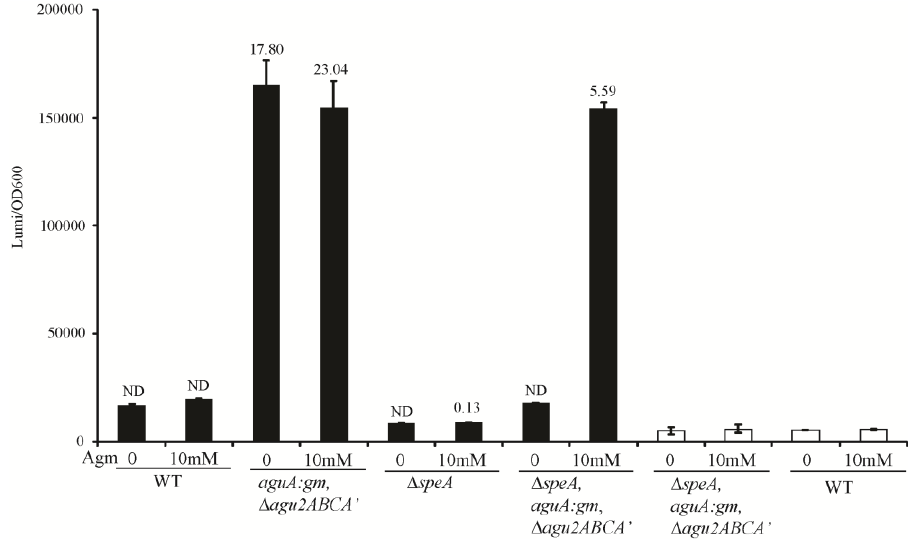
Figure 4. Agmatine titration in the agmatine biosensor. Each well contains 1 × 10 6 CFU of either the agmatine biosensor (  speA , aguA:gm ,  agu2ABCA’, aguRB:lux ) or its vector control (  speA , aguA:gm ,  agu2ABCA’, ctx:lux ) in 200  L of LB broth with the indicated concentration of stimulant. The y-axis shows the relative luminescence/OD 600 at 3 h of growth. Error bars are SEM of three wells.